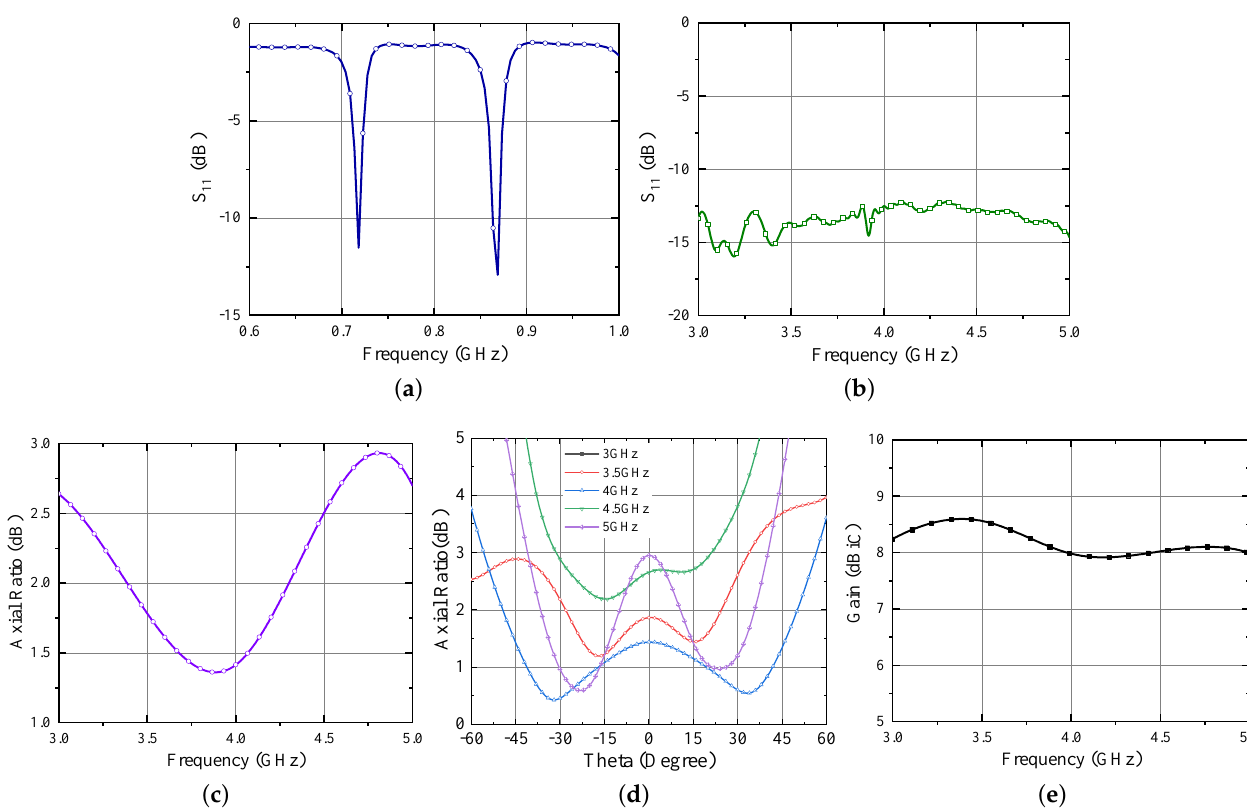
Figure 8. Simulated responses of hybrid UWB antenna ( a ) S 11 for UHF band (normalized to 12 Ω ) ( b ) S 11 for UWB band (normalized to 120 Ω ) ( c ) Axial Ratio v/s Freq ( d ) Axial Ratio v/s Theta ( e ) Gain.